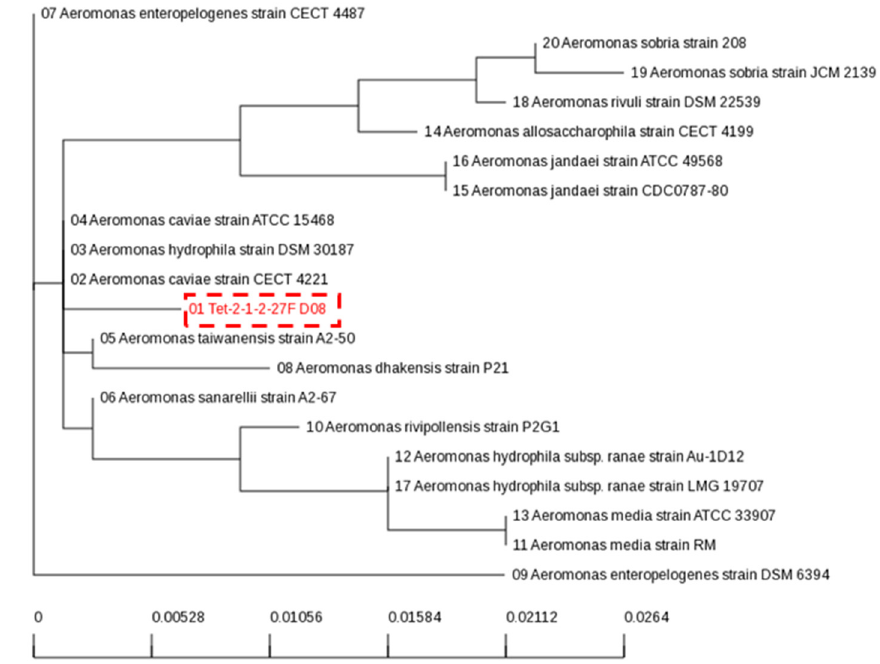
Figure 1. Phylogenetic analysis of 16S rRNA gene sequencing of isolated MDR-bacteria and inter- species relationship with genus of Aeromonas spp.